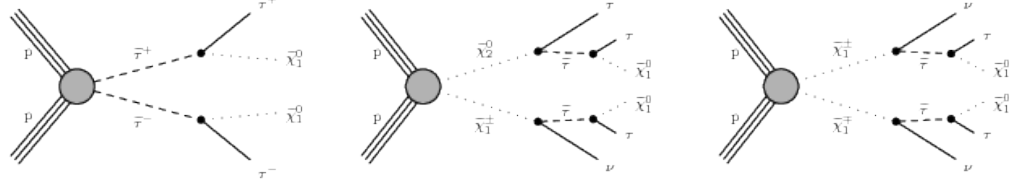
Figure 6: Diagrams for the simplified models: direct ˜ τ pair production followed by ˜ χ 0 each ˜ τ decaying to a τ lepton and (left), and chargino-neutralino (middle) and 1 chargino pair (right) production with subsequent decays leading to τ leptons in the final state [ 15 ]